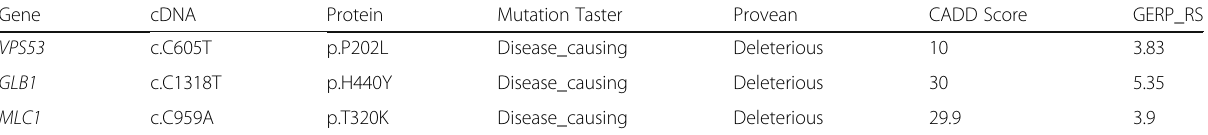
Table 1 Variants identified in the families with ID and neurodevelopmental disorders